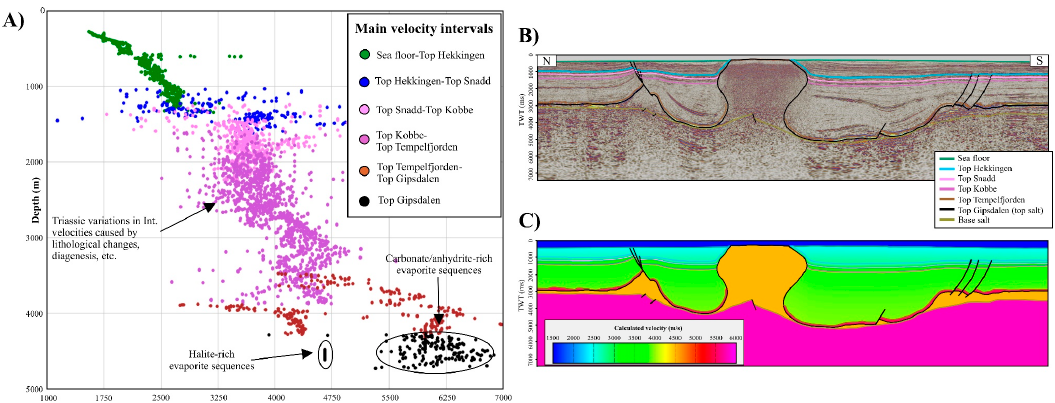
Figure 3. ( A ) Plot showing calculated interval velocities vs depth from wells 7228/9-1, 7228/7-1A, 7125/1-1, 7124/3-1, 7229/11-1. ( B ) Seismic section B showing the location of the main velocity transitions. ( C ) Seismic section B displaying the interval velocities used to depth convert the seismic profile (modified from Rojo et al. [18]).